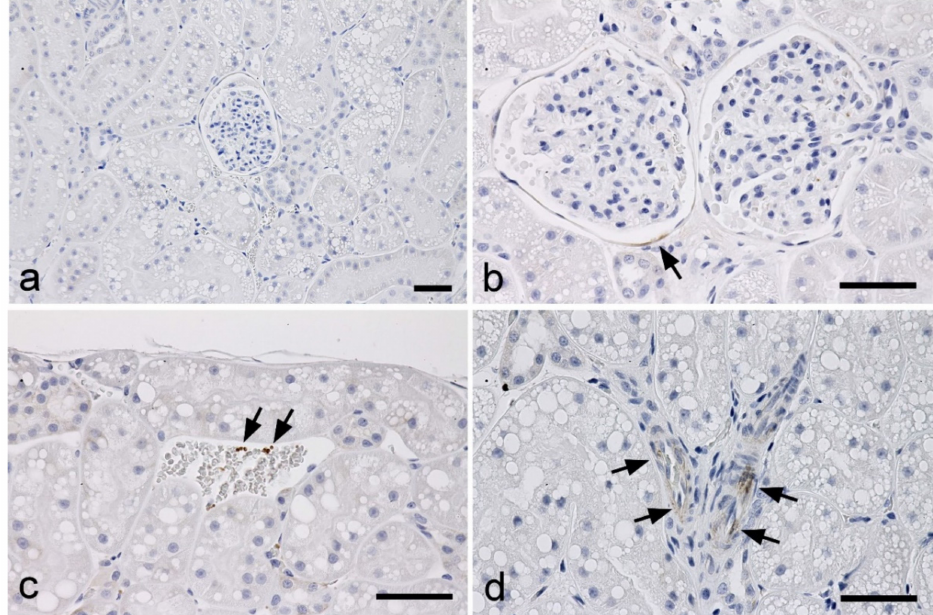
Figure 1. Immunohistochemistry for the detection of TGF- β 1 in the kidneys of normal cats. ( a ) No immunolabeling is observed in the cortex. ( b ) A portion of the external walls of Bowman’s capsules showing faint signals (arrow). ( c ) A few platelets of the vascular system showing positive signals (arrows). ( d ) Some vascular smooth muscles showing weak positive signals (arrows). Scale bar: 50 µ